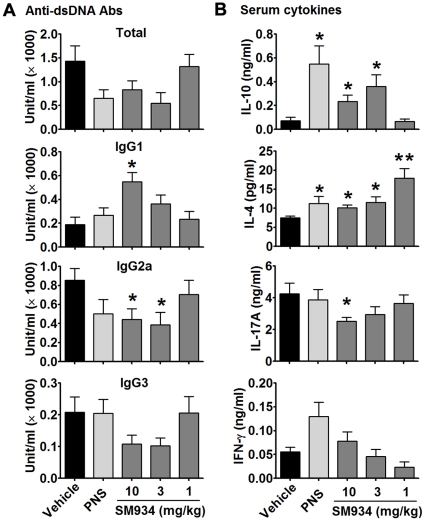
SM934 treatment regulated anti-dsDNA autoantibodies and cytokines in sera.At the termination of 3 months treatment, sera of female NZB/W F1 mice were collected and examined for anti-dsDNA autoantibodies and cytokines. (A) Serum levels of anti-dsDNA total IgG, IgG1, IgG2a and IgG3 antibodies. Sera of 10 months old female NZB/W F1 mice were used as the standard control. (B) Serum levels of IL-10, IL-4, IL-17A and IFN-γ. Shown were mean ± SEM. * = P<0.05; ** = P<0.01 versus vehicle.